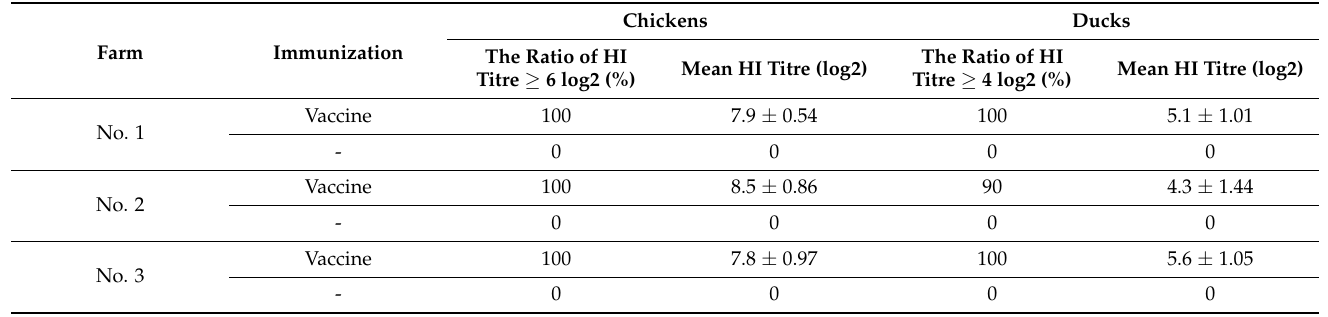
Table 5. Percentage of seroconversion of vaccinated birds by the inactivated vaccine in the farms.